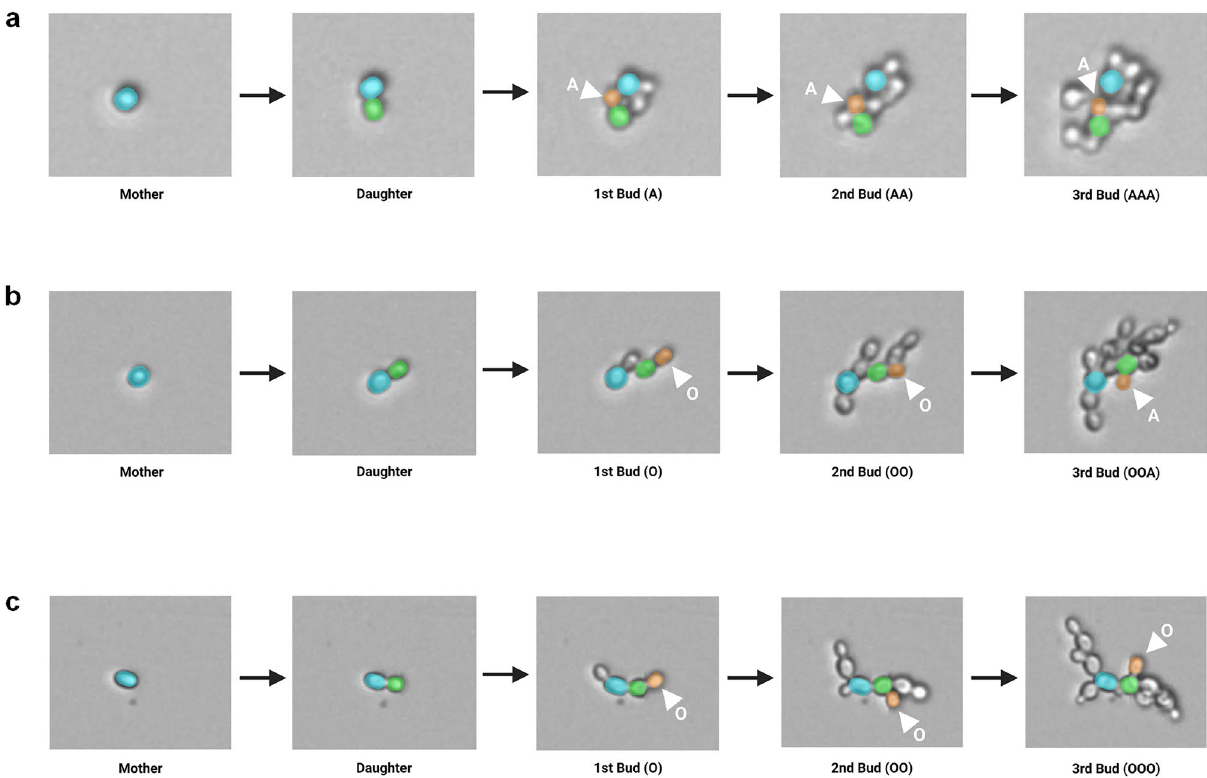
Figure 2. Representative cropped time-lapse images of a new daughter cell being assigned a budding pattern by using its bud site sequence. Time-lapse images were obtained with the oCelloScope™ with bud site sequences categorised according to Fig. 1. ( a ) Strain S288c undergoing axial budding with a bud site sequence of AAA. ( b ) Strain Σ1278b undergoing bipolar budding with a bud site sequence of OOA. ( c ) Strain Σ1278b undergoing unipolar budding with a bud site sequence of OOO. (Cell colors were manually added to oCelloScope™ images for illustrative